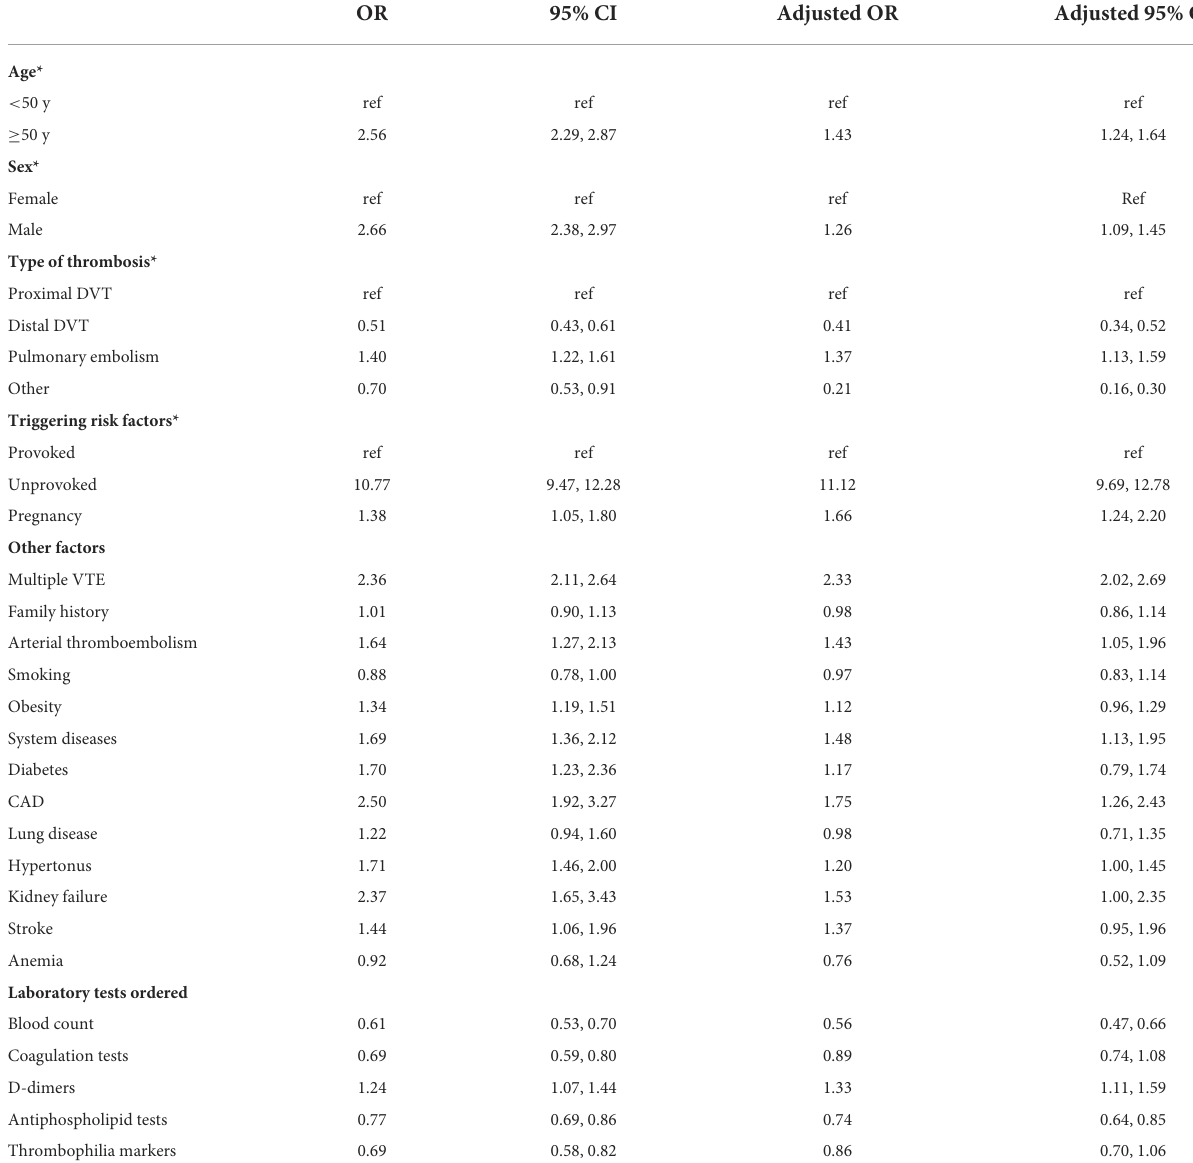
TABLE 3 Predictors of guideline adherence in a single center prospective cohort study ( n =